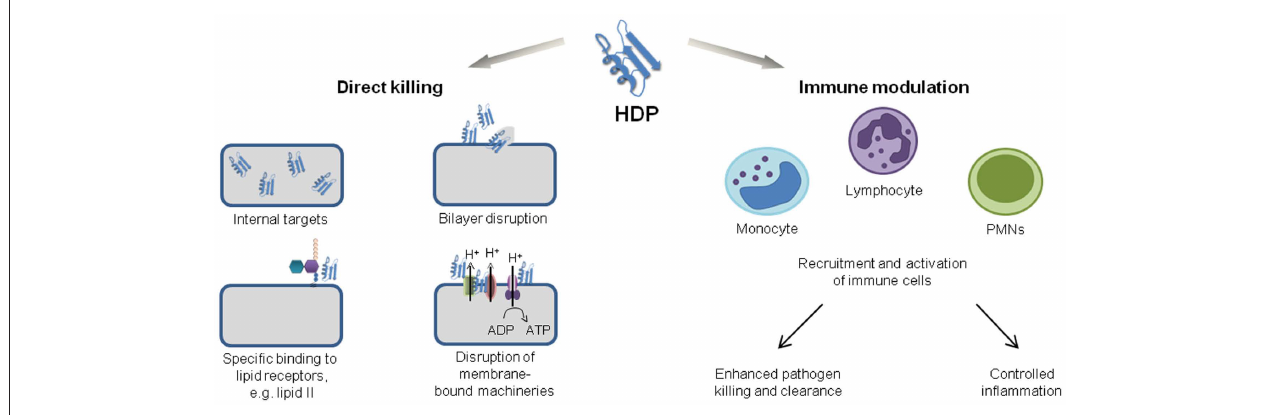
Figure 1 | Functions of